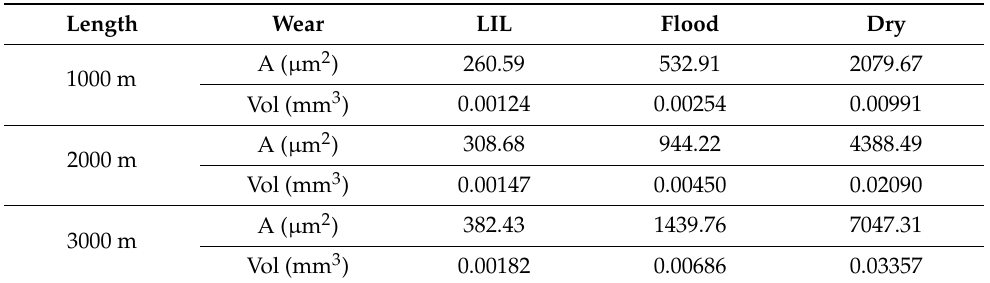
Table 3. Average wear area (A) and wear volume (Vol) in the insert in pin-on-disk experiments of the pair Cu-Ni alloy-tool insert.